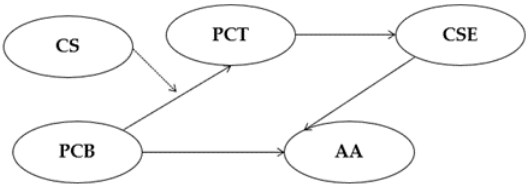
Figure 3. The mediation pathway of Hypothesis 2. Note. PCB = Perceived crime benefit, PCT = Proactive criminal thinking, CSE = Criminal self-efficacy, AA = Arrest avoidance, CS = Crime strategy. The bold lines refer to mediation pathways (Hypothesis 2a), and the dashed line to a moderation pathway (Hypothesis 2b).